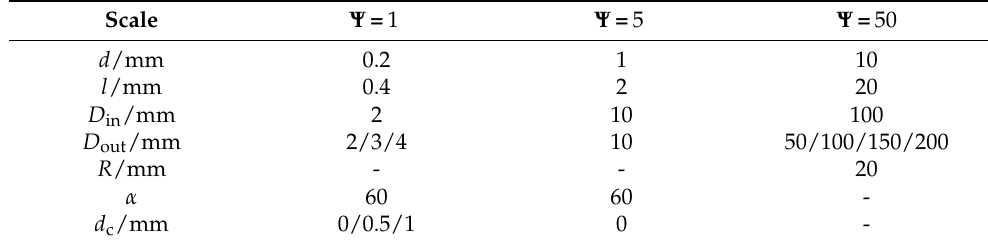
Table 2. Dimensions of all orifice